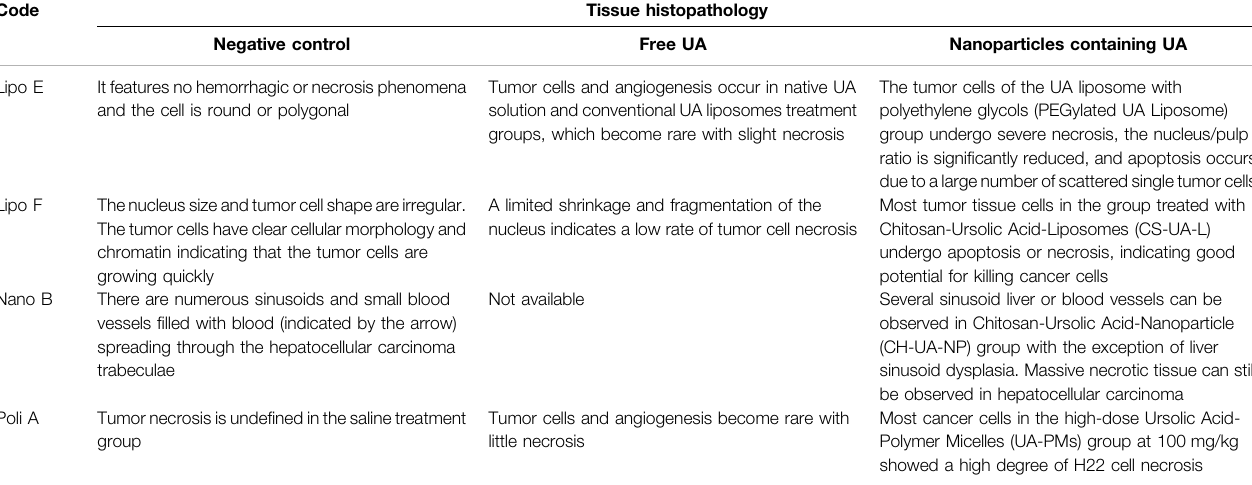
TABLE 5 | Tissue histopathology of liver cancer after administration of negative control, native UA and nanoparticles containing